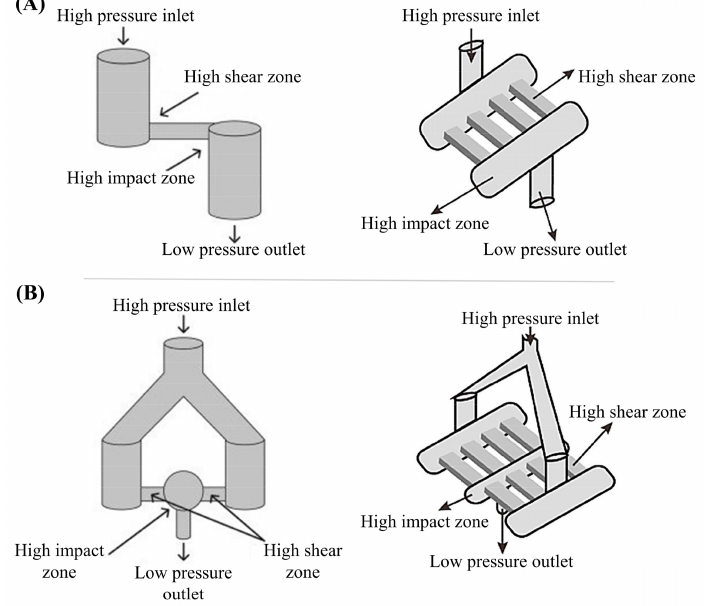
Figure 4. Two geometries of interaction chamber in high-pressure microfluidizer. ( A ) Z-type with single and multiple channels; ( B ) Y-type with single and multiple channels (Reproduced with permission from Refs. [50,51]. Copyright 2018 and 2016